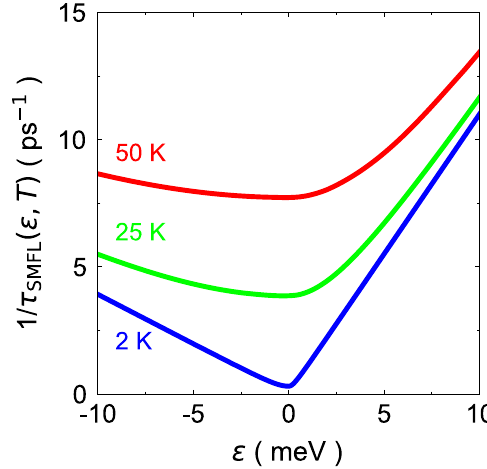
FIG. 9. Energy dependence of the skewed marginal Fermi- ð ϵ ; T Þ at T ¼ 2 , 25, and 50 K. liquid scattering rate 1 = τ SMFL 1 = τ is defined by Eq. (3) with parameters given in Table SMFL